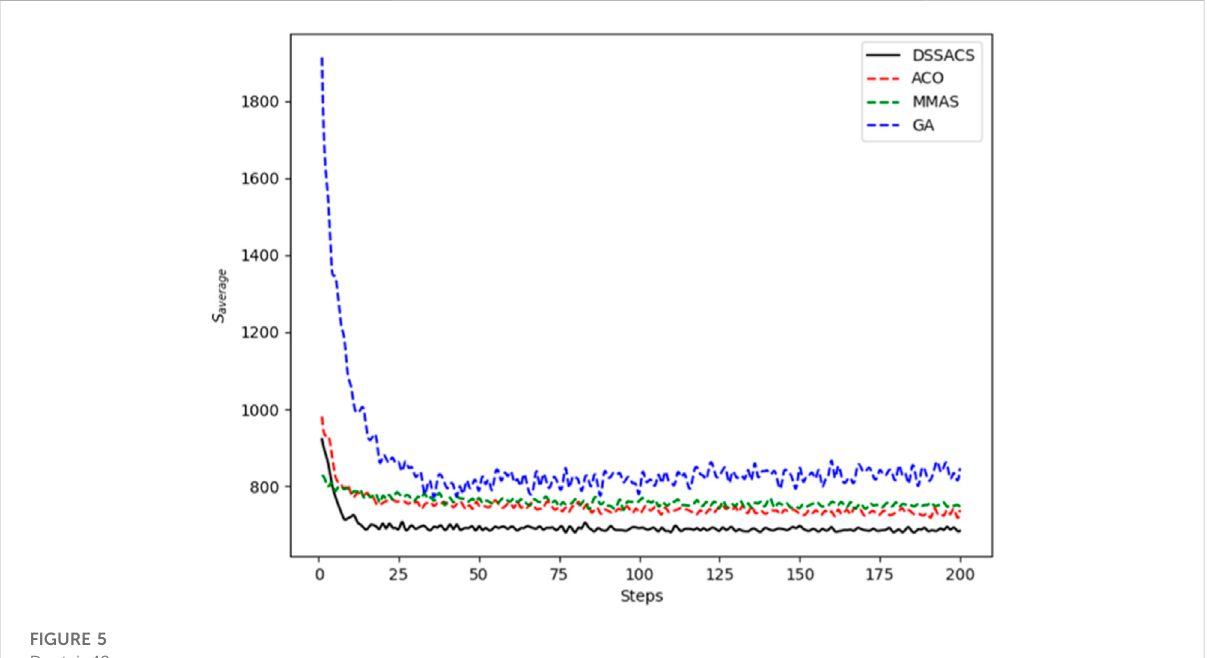
FIGURE 5 Dantzig42.